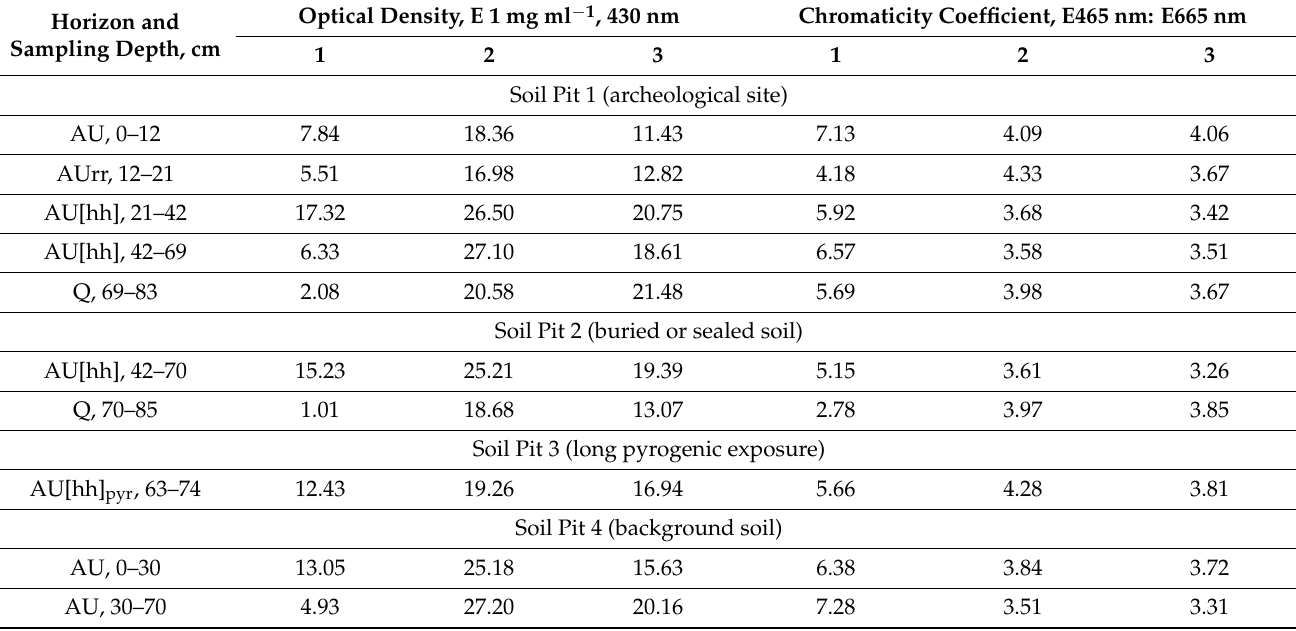
Table 4. Optical density and chromaticity coefficient for HA